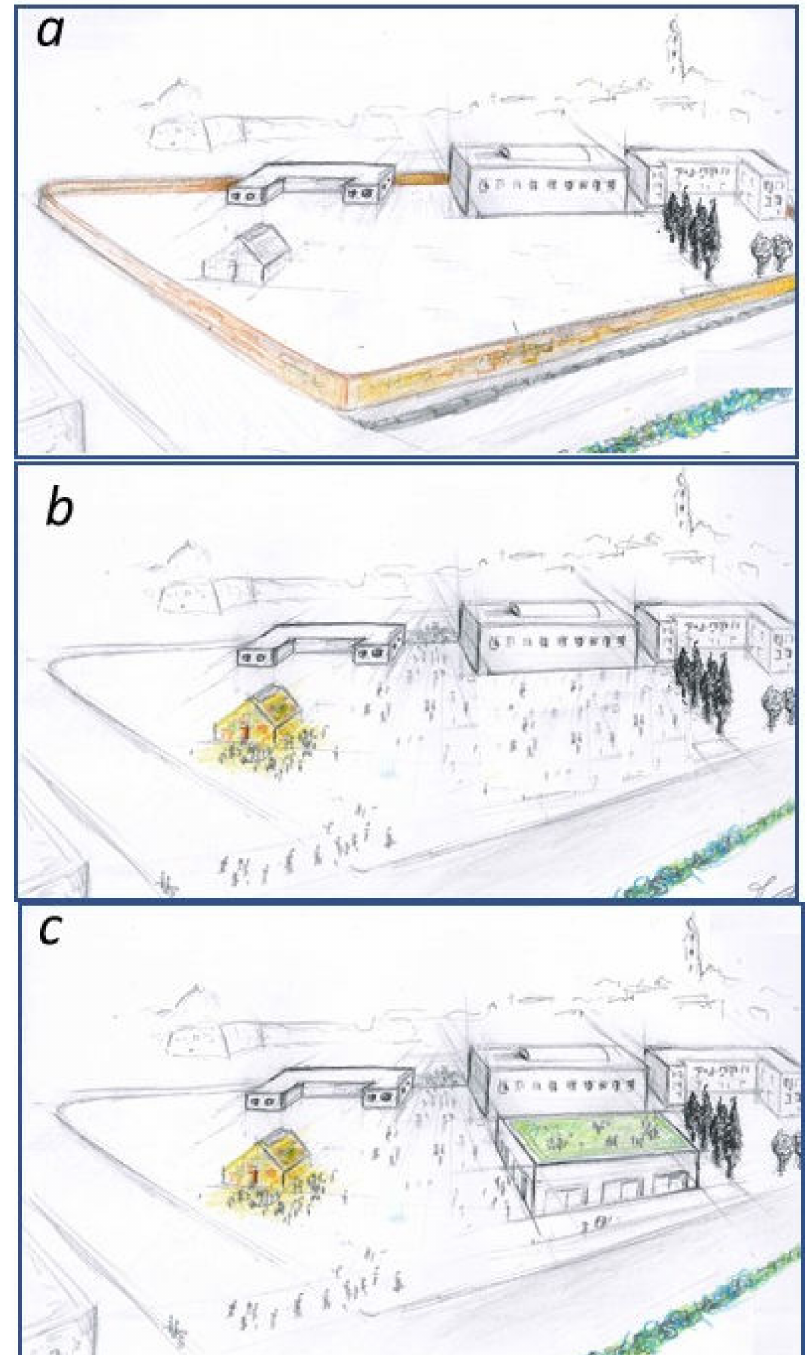
Figure 13. ( a ) schematic representation of the actual state of the area; ( b and c ) draft of the potential evolution of the area following and interpreting the indications of the respondents and discussion with the citizens, designers, and decision-makers. This figure represents a simple scientific exercise and does not have legal or institutional value or what this area will be in the